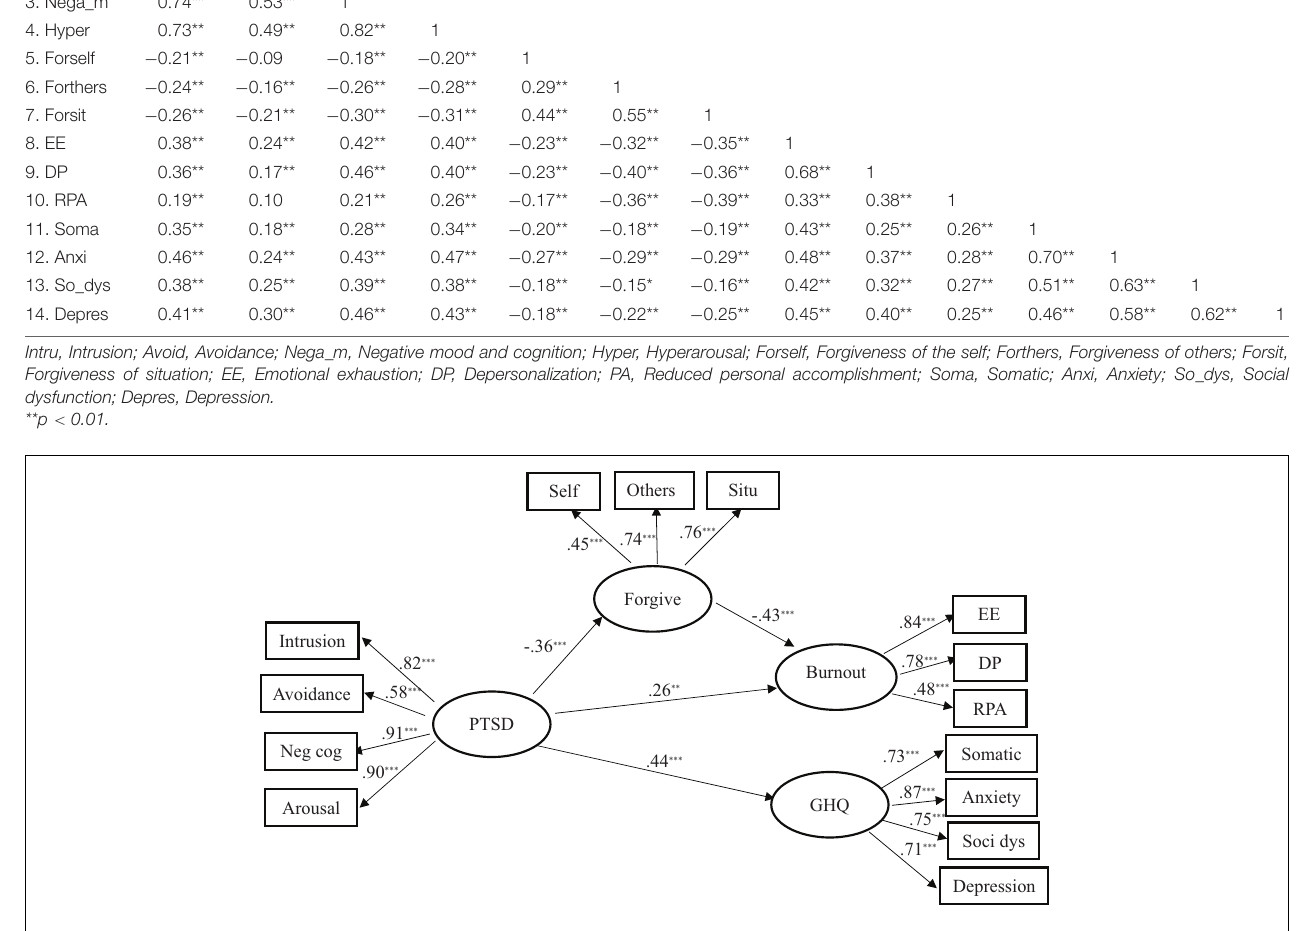
(workload, student misbehavior, role conflict and ambiguity, and perceptions of school climate), PTSD symptom severity was positively associated with levels of burnout and psychiatric co-morbidity; forgiveness was negatively correlated with PTSD and burnout rather than psychiatric co-morbidity. Teachers who scored high on PTSD were less forgiving which was associated with burnout